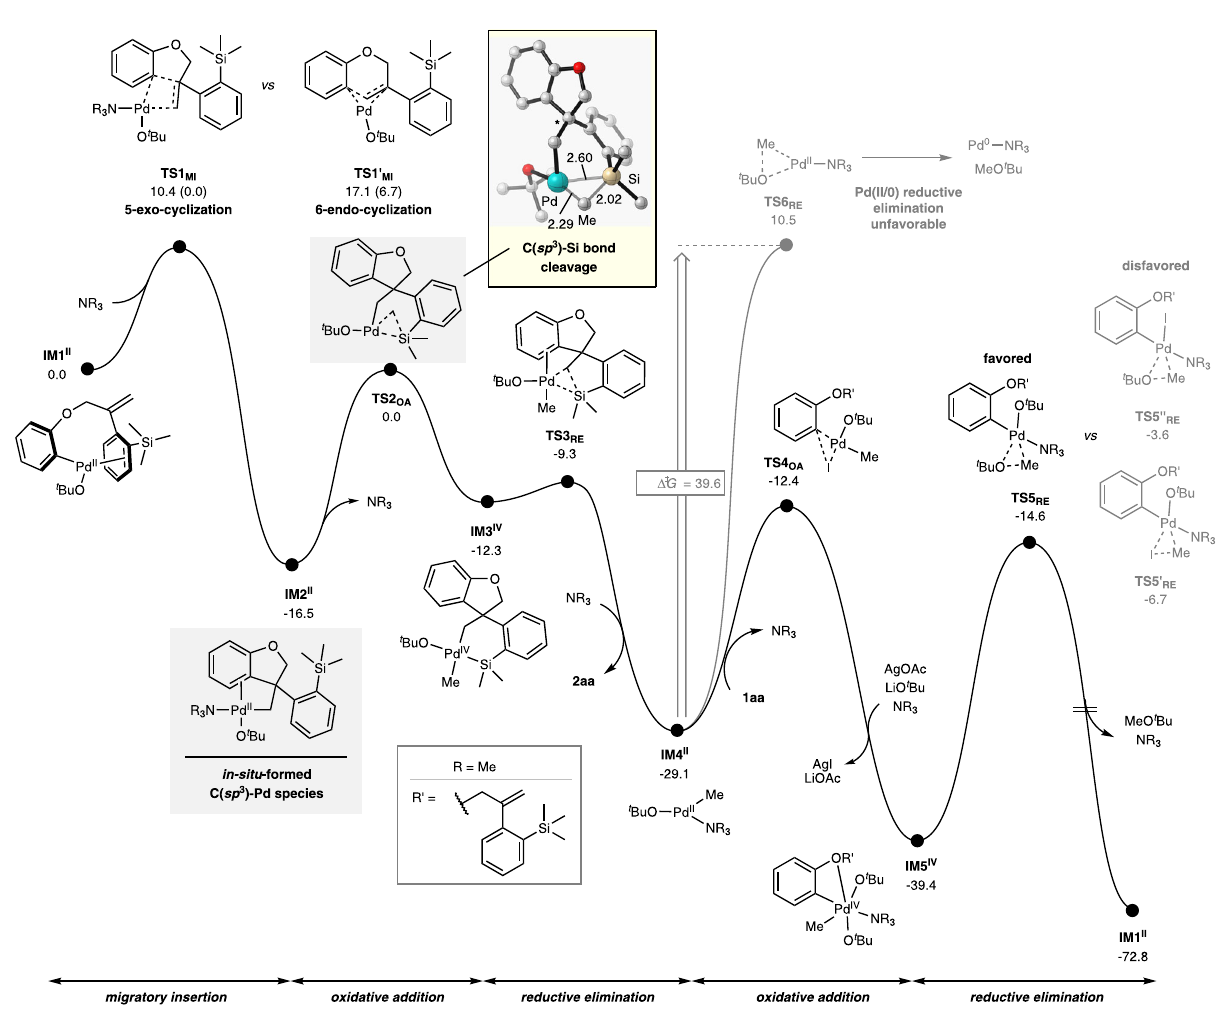
Fig.5|Freeenergypro fi leforproposedcatalyticmechanismofthisreaction.